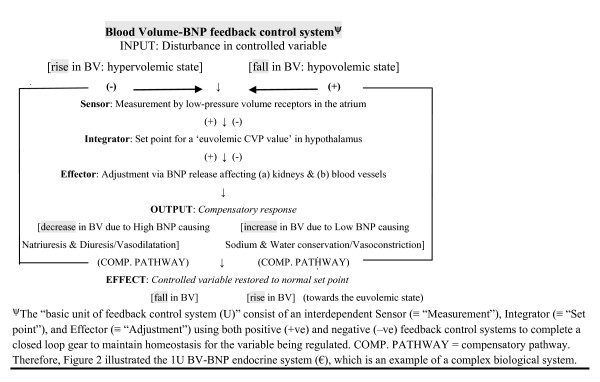
Blood Volume – B-type natriuretic peptide feedback control system. BV; Blood volume, CVP; Central venous pressure, BNP; B-type natriuretic peptide.